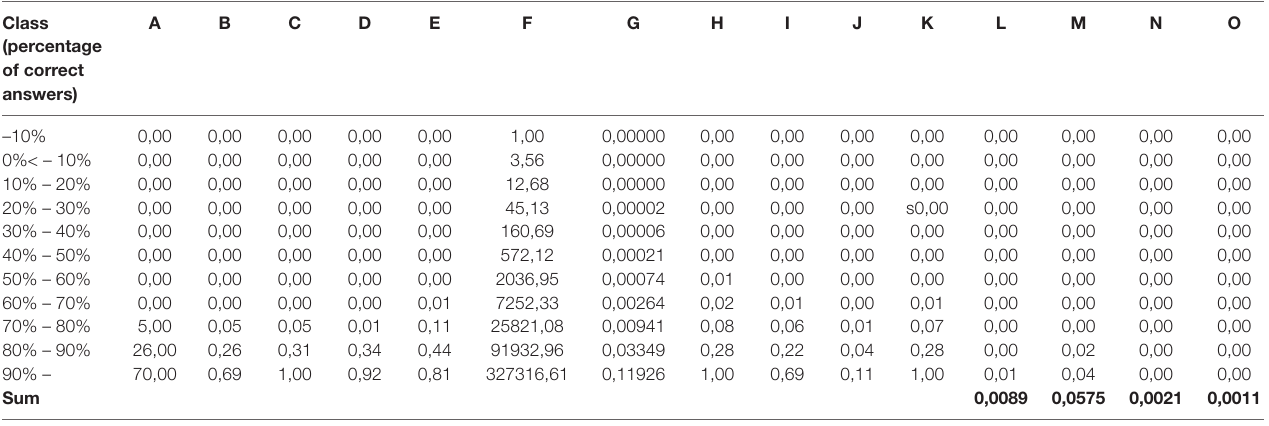
TABle 2 | An example for the calculation of sum of squared residuals (SSR) based on the data of the CG in the Prosody condition. Class (percentage